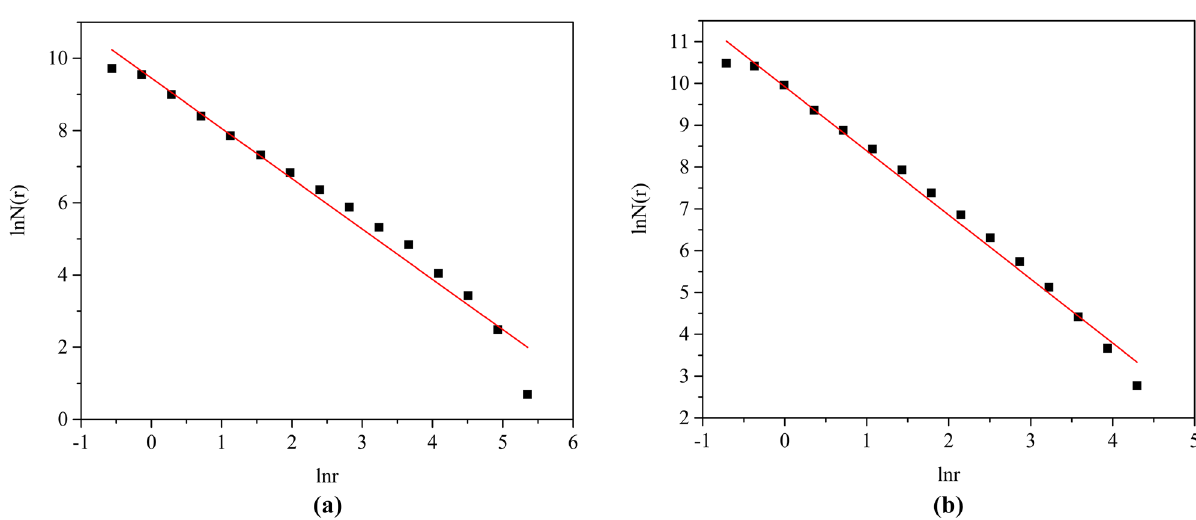
Figure 9. Determination of fractal dimension D: ( a ) untreated loess; ( b ) lime-treated loess.